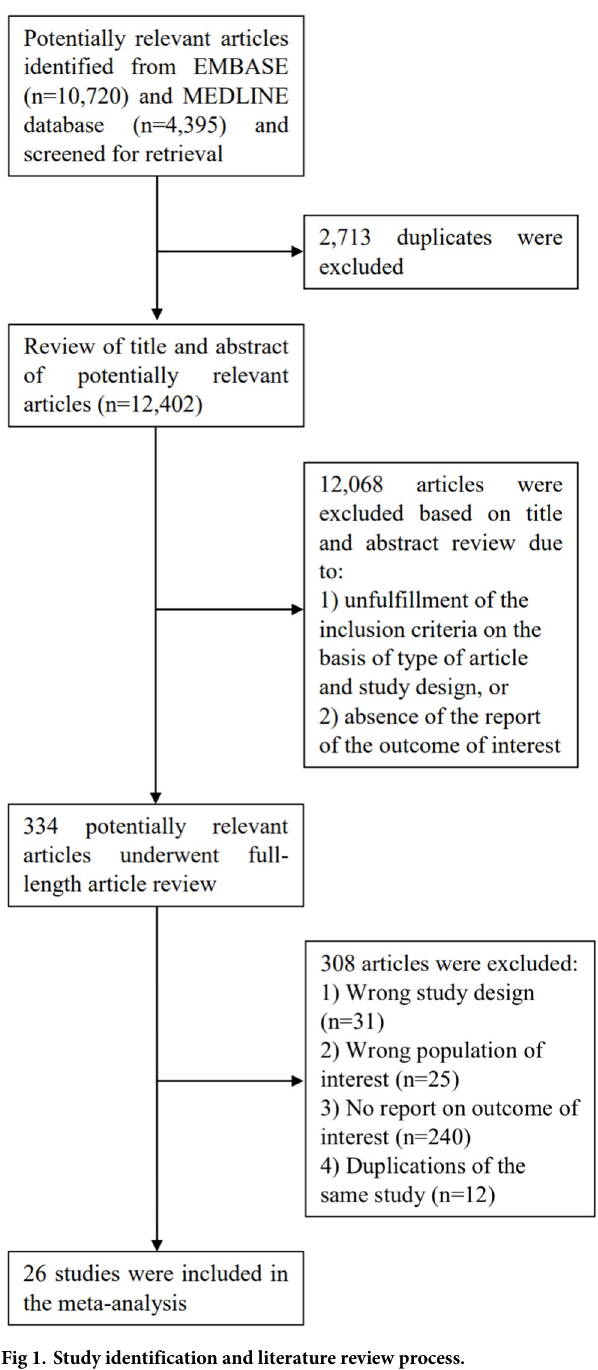
Fig 1. Study identification and literature review